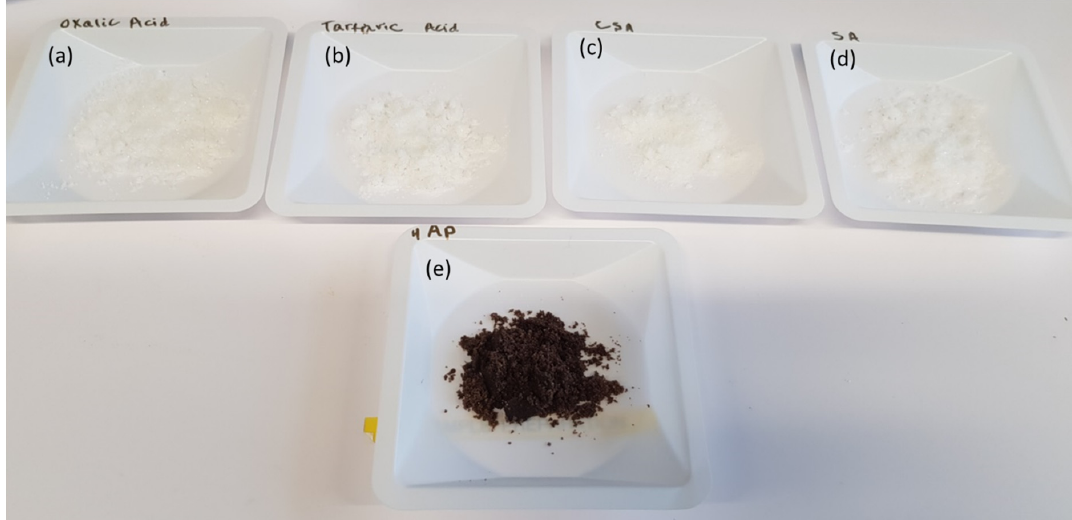
Figure 5. Crystallization experiments: ( a ) PA+PAP+OX, ( b ) PA+PAP+TA, ( c ) PA+PAP+CSA, ( d ) PA+PAP+SA, and ( e ) PA+PAP.